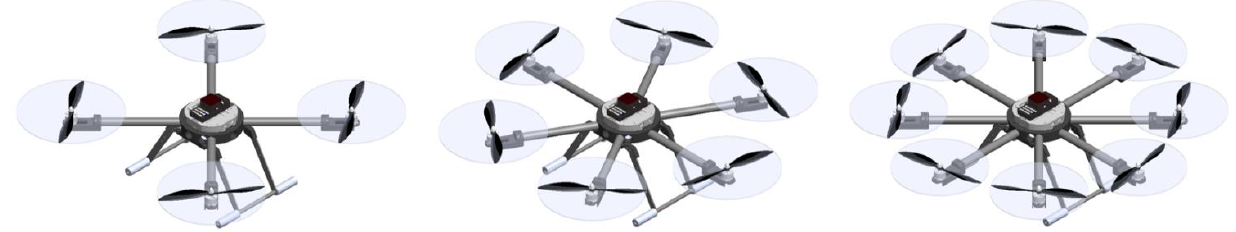
Figure 1. Generic conventional multirotor configurations.